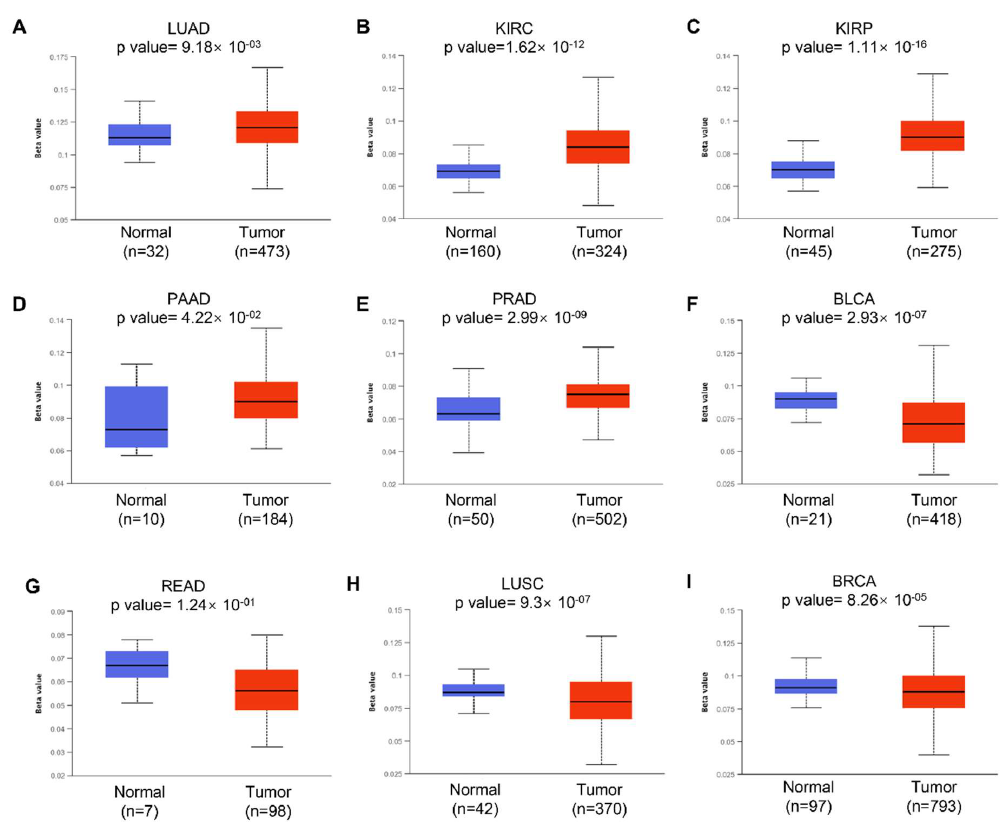
Figure 3. Histogram bars showing the hyper- or hypomethylation of the KRAS promoter region in tumors compared to normal tissues in LUAD ( A ), KIRC ( B ), KIRP ( C ), PAAD ( D ), PRAD ( E ), BLCA ( F ), READ ( G ), LUSC ( H ), and BRCA ( I ). A p -value < 0.05 was considered a significant threshold.